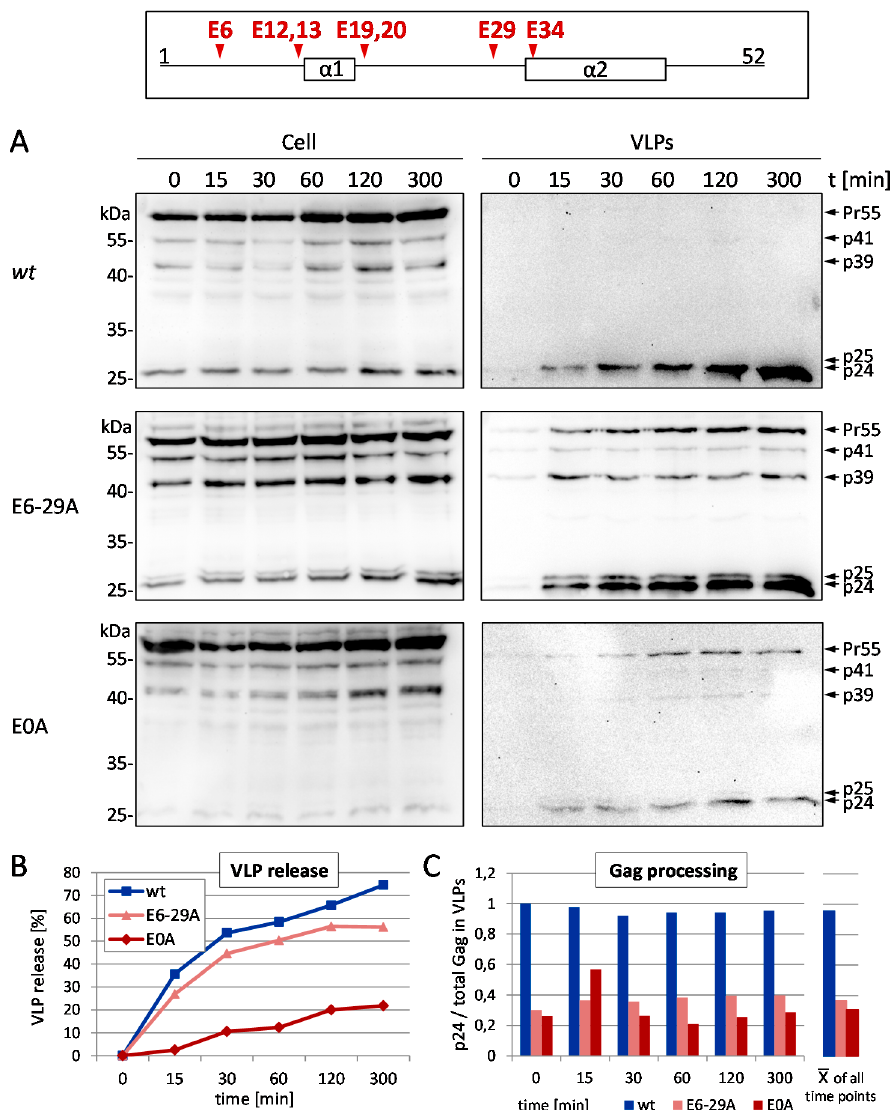
Figure 3. Mutation of all glutamic acids within p6 inhibits VLP release and Gag maturation. ( A ) HeLa cells were transiently transfected with pNL env 1 wt or the Glu mutants E6-29A and E0A. VLP release was quantified by western blot time course analyses; ( B ) The percentage of VLPs released over time was calculated as the amount of CA detected in the VLP fraction versus the total amount of Gag recovered from cell and VLP fractions; ( C ) Gag processing was calculated as the amount of CA relative to the total amount of Gag in the VLP fraction. Values on the y -axis was adjusted to 1 for wt at t = 0.